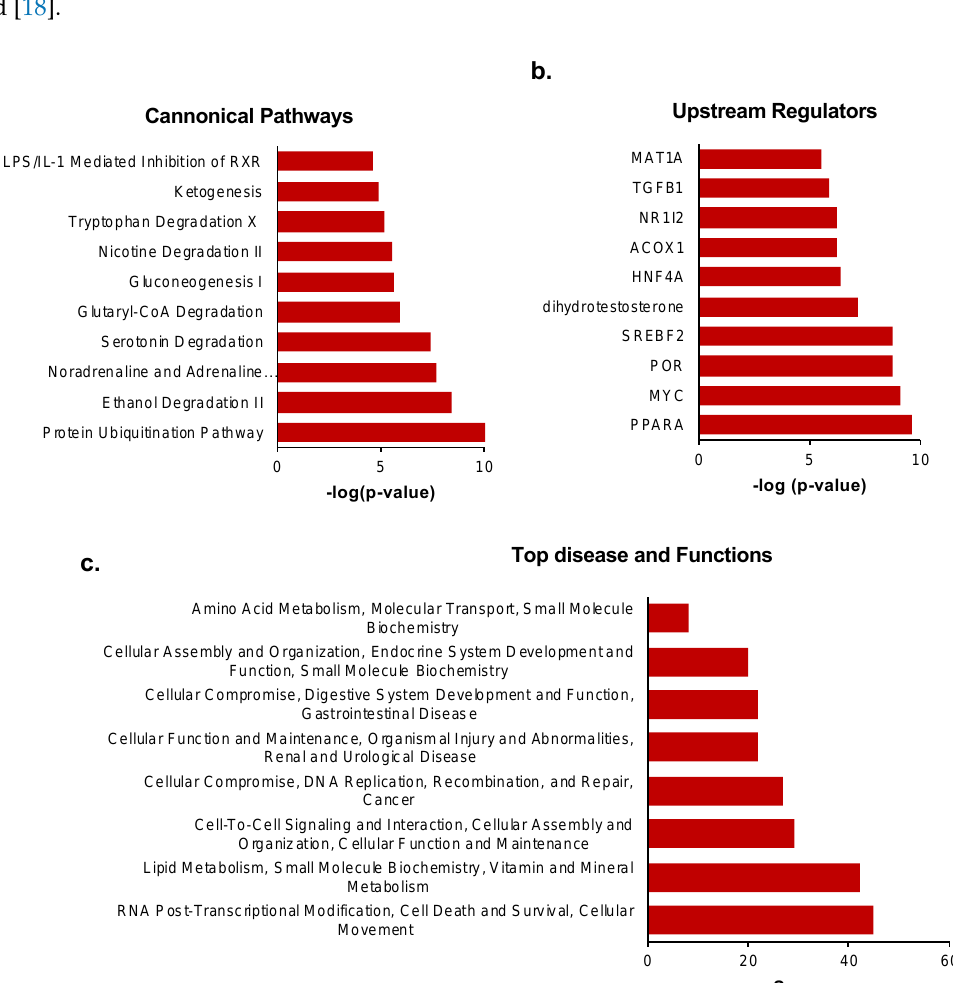
Figure 5. Ingenuity Pathway Analysis (IPA ® ) was performed to understand the principal pathways affected by ubiquitination after carbon tetrachloride (CCl 4 )-induced liver fibrosis. IPA analysis retrieving the ( a ) Top canonical pathways, ( b ) Upstream regulators, and ( c ) Top diseases and Functions of the differentially expressed ubiquitinated proteins identified by mass spectrometry using the bioubiquitin ( bio Ub) and the BirA mice as a result of CCl 4 -induced liver fibrosis.